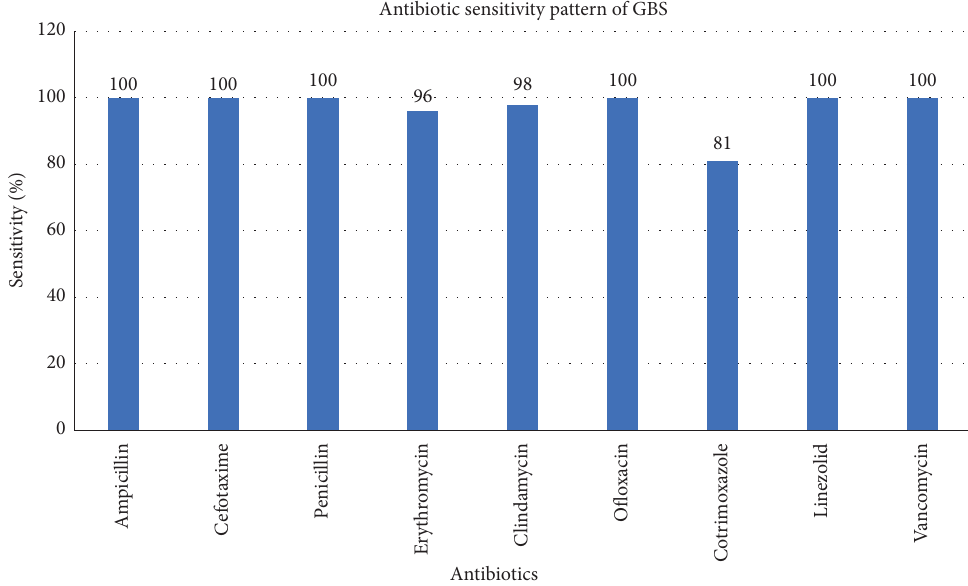
Figure 3: Antibiotic sensitivity pattern of GBS isolates. Table 3: Serotype distribution and pattern of antimicrobial resistance among S.agalactiae isolates.